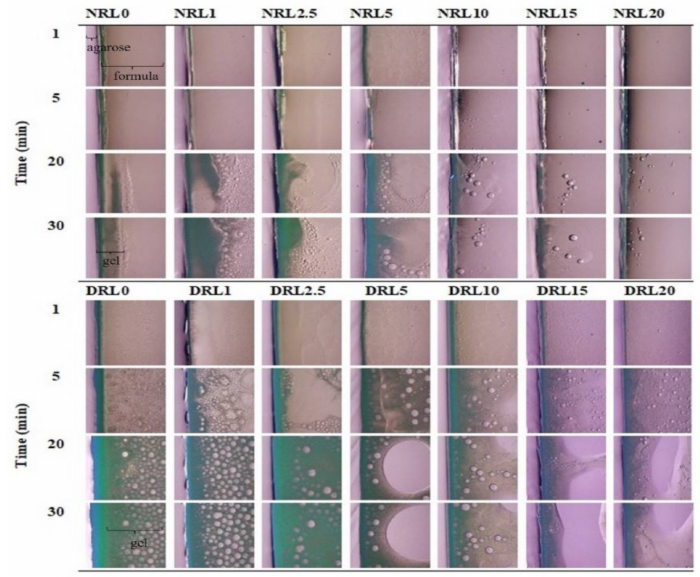
Figure 3. Interfacial phenomena changes of rosin in situ gel with different concentrations of LO after contact with aqueous agarose gel phase under stereomicroscope with various time intervals (40 ×